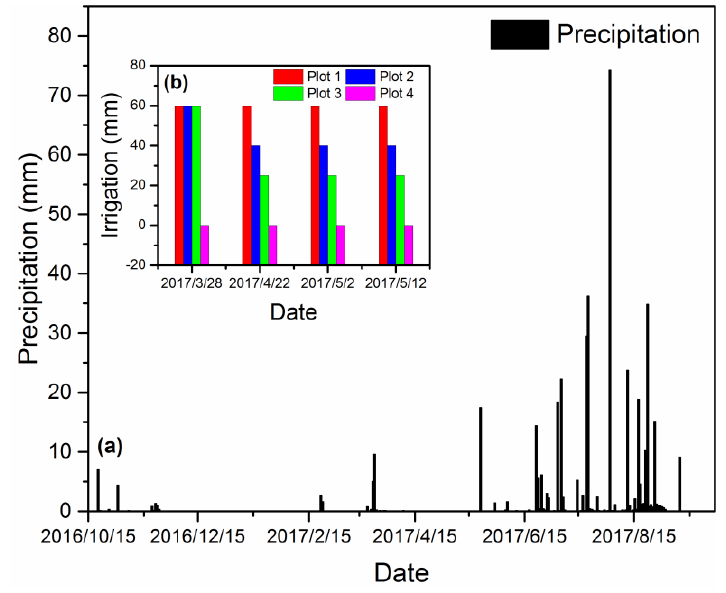
Figure 2. ( a ) Precipitation during the period from 15 October 2016 to 29 September 2017, covering the time periods for the field campaigns for wheat and maize. ( b ) Gradient irrigation treatments applied over the four plots of wheat.